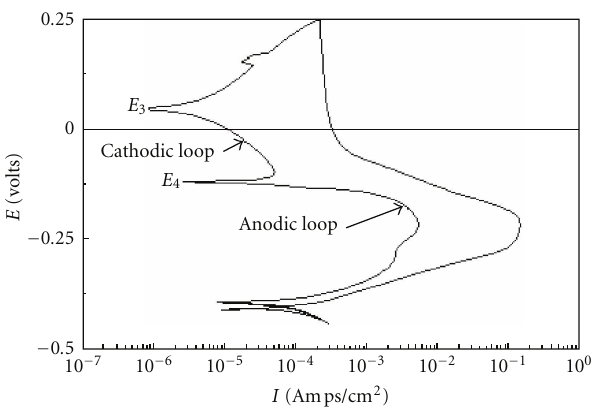
Figure 9: Cathodic and anodic loops in DLEPR